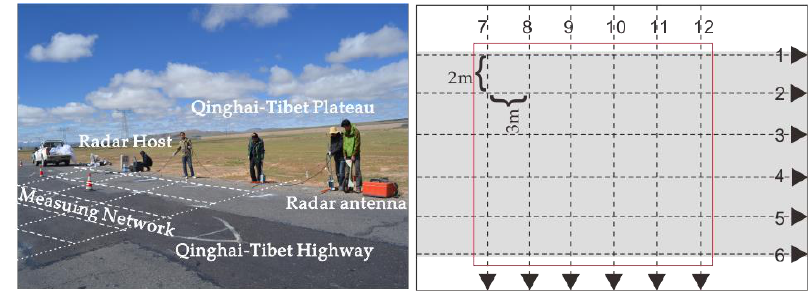
Figure 2. Test experiment and measurement line layout.